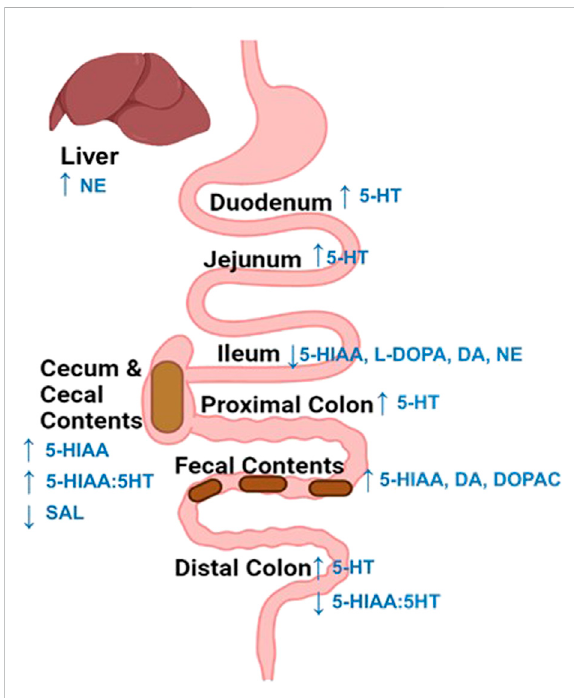
FIGURE 6 Summary of stress-induced changes to neurochemicals across the intestines and liver. An increase (up arrow) in 5-HT or its metabolite concentration were overserved across most intestinal regions 48 h following stress exposure. Whereas, catecholamine related neurochemicals were only notably altered intheIleum,whichdisplayedareduction(downarrow)inL-DOPA, dopamine, and norepinephrine content. Finally, exposure to stress reduced (down arrow) salsolinol (SAL) concentrations in the